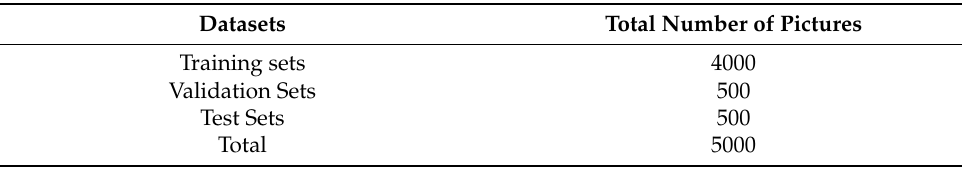
Table 1. Classification results of the dataset at training.